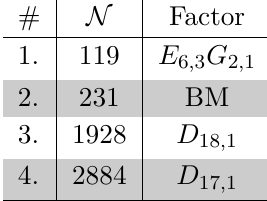
Table 26. List of meromorphic theories ruled out by table